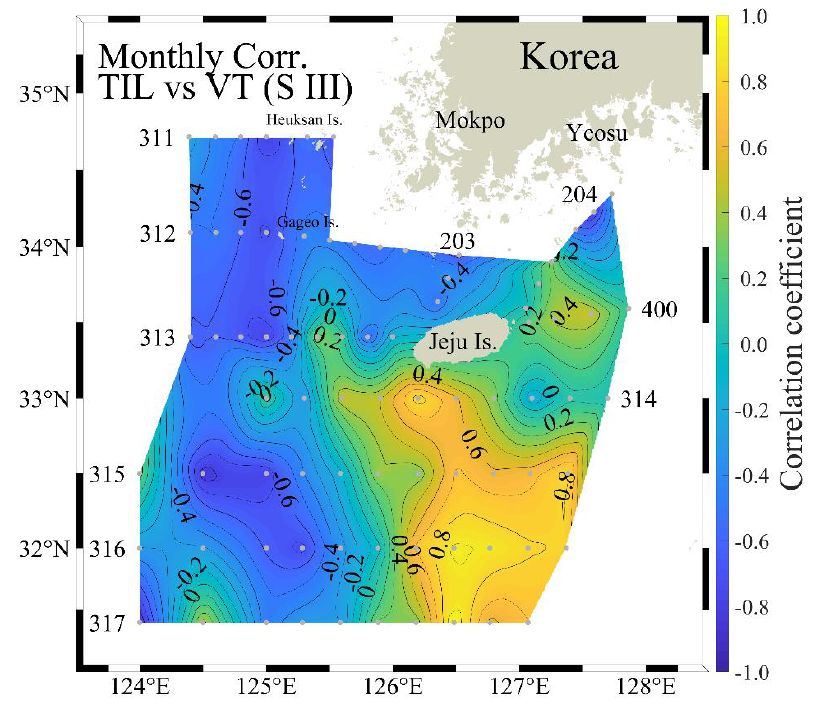
Figure 9. The distribution of the correlation coefficient for the monthly mean of the Sector III volume transport and the percentage of TIL at all stations.